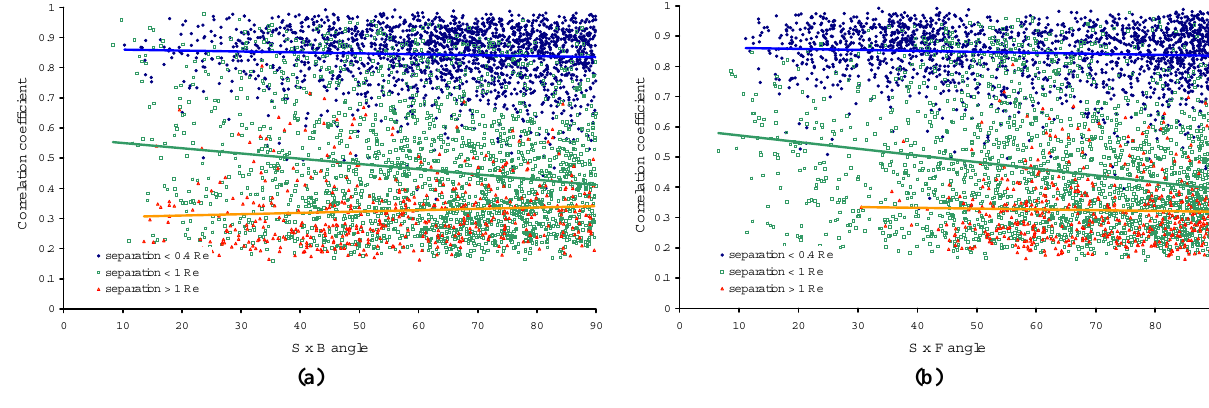
Fig. 10. Cross-correlation coefficients as a function of the angle between the s/c separation and averaged magnetic field vectors, S × B (a) and the angle between the s/c separation and ambient plasma velocity vectors, S × F (b) . The events are grouped according to the length of the s/c separation and linear fits are shown for each